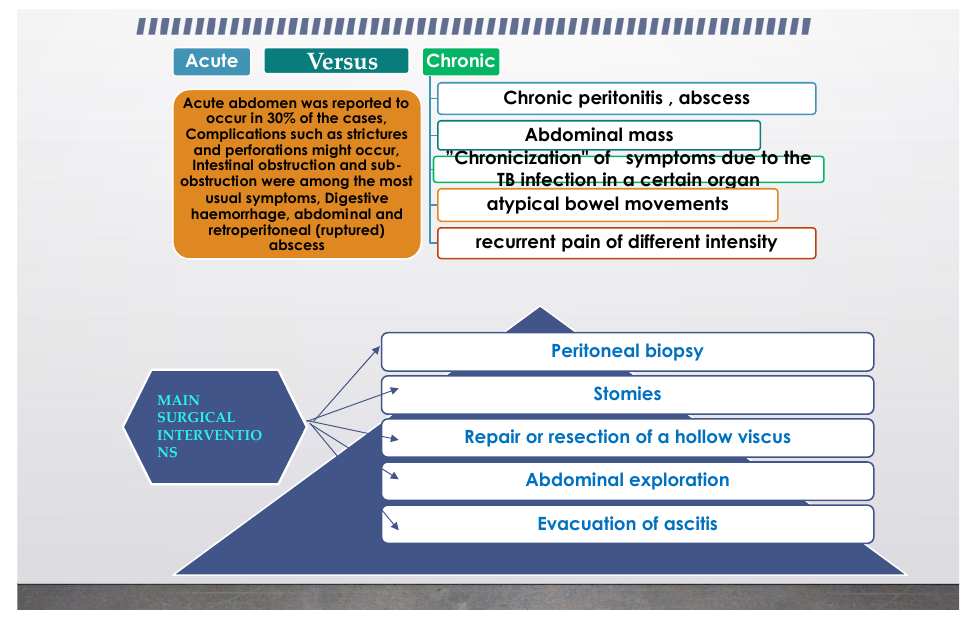
Figure 4. Common surgical setting characteristics in abdominal tuberculosis. When TB associates with ascitis, ultrasound can detect even a small amount and show fine, multiple strands of fibrin, septations, and debris. A computed tomography exam can show the high density of fibrin and cellular debris or water density in the initial transitive phase, or even the fat fluid level due to chylous ascitis. A magnetic resonance imaging exam can show delayed enhancement (15 – 20 min) after i.v. contrast.